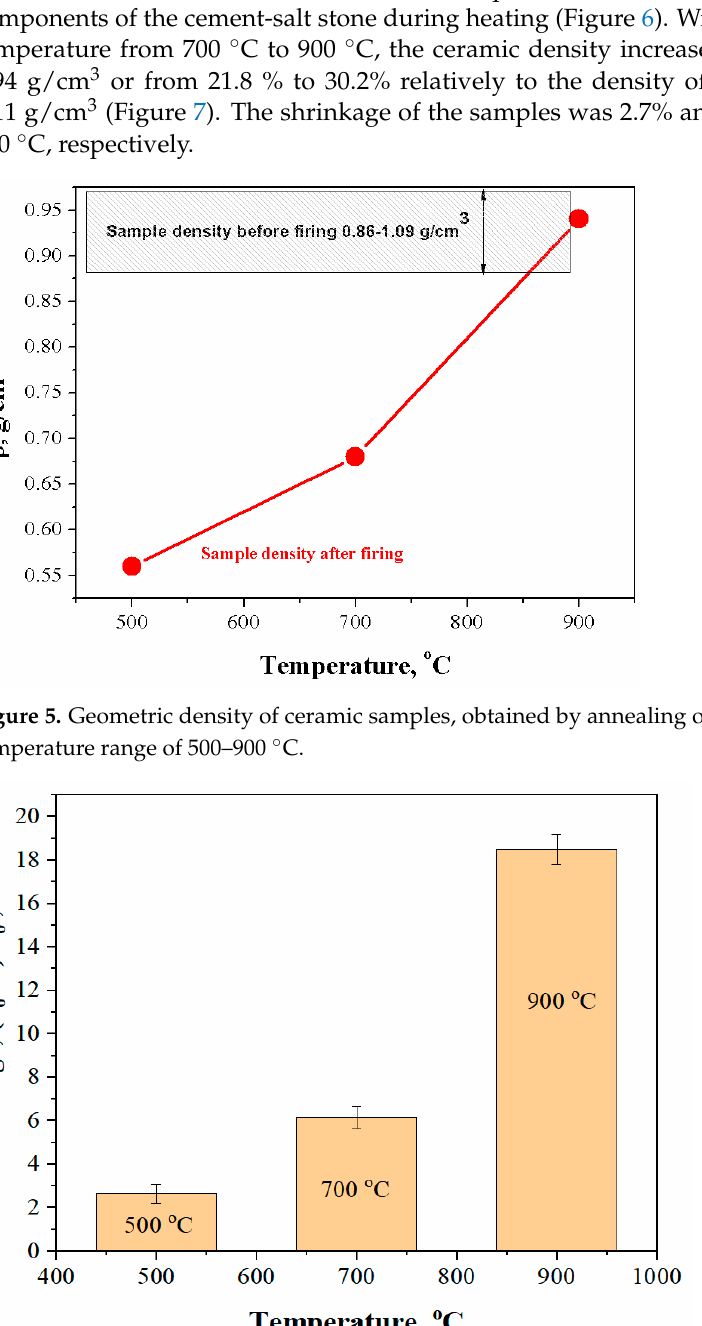
Figure 4. The XRD of ceramic samples based on cement-salt stone prepared from powder mixture of calcium citrate tetrahydrate and sodium dihydrogen phosphate in the temperature range of 500– 900 °C. x— β -CaNaPO 4 (PDF 29-1193); h—Ca 10 (PO 4 ) 6 (OH) 2 (PDF 74-565); +— β -Ca 3 (PO 4 ) 2 (PDF 9-169);